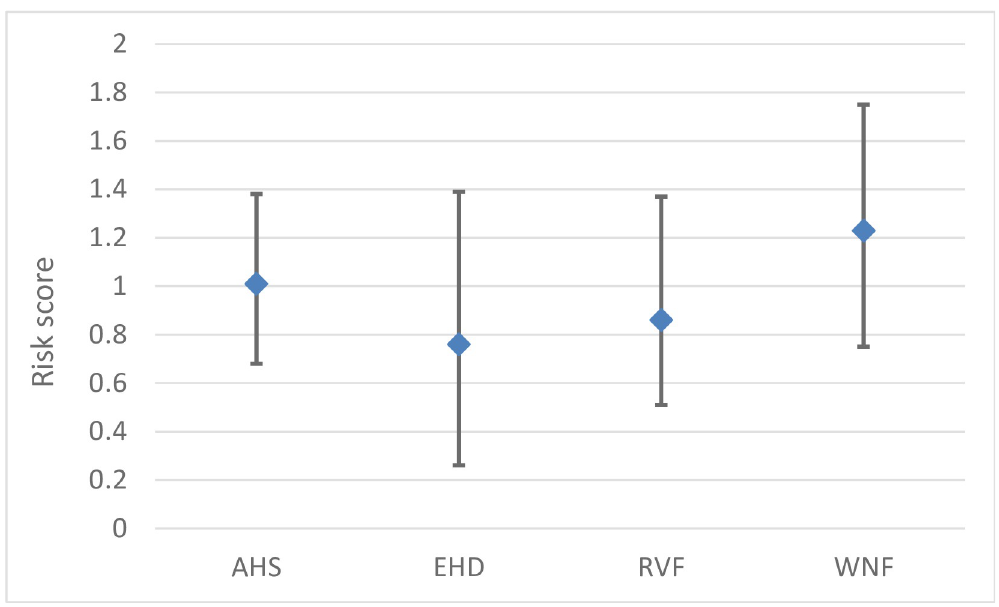
Fig 6. Risk scores (median values) and their uncertainty (95% uncertainty interval) for the overall risk estimate of four vector-borne diseases for the Netherlands. AHS = African horse sickness; EHD = epizootic haemorrhagic disease; RVF = Rift Valley fever; WNF = West Nile